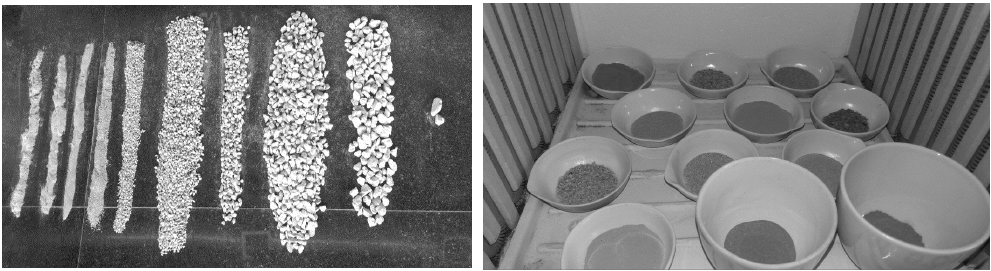
Figure 3. Crushing processes to obtain the RCA.